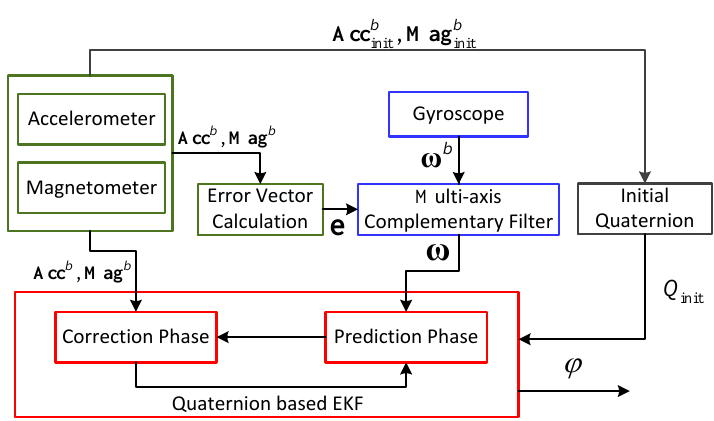
Figure 5. Block diagram of heading